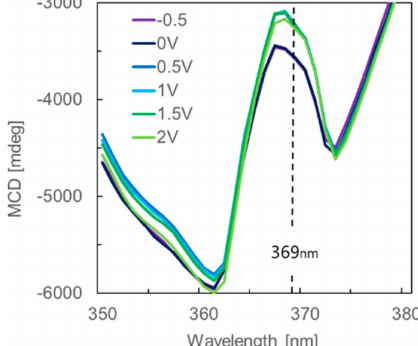
Figure 12. Voltage-induced modulation of the MCD. The sample structure was a glass substrate with indium tin oxide (100 nm), along with Bi:YIG (170 nm) and Al:ZnO (200 nm). The voltage was applied from Al:ZnO to indium tin